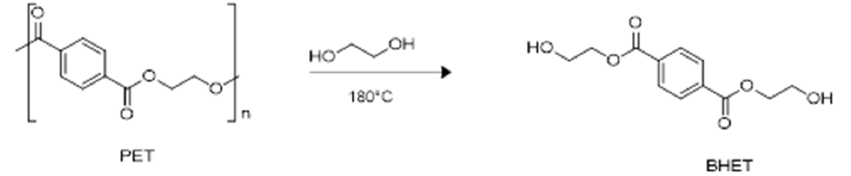
Table 3. Glycolysis of PET under solvent-free conditions at 180 ◦ C.